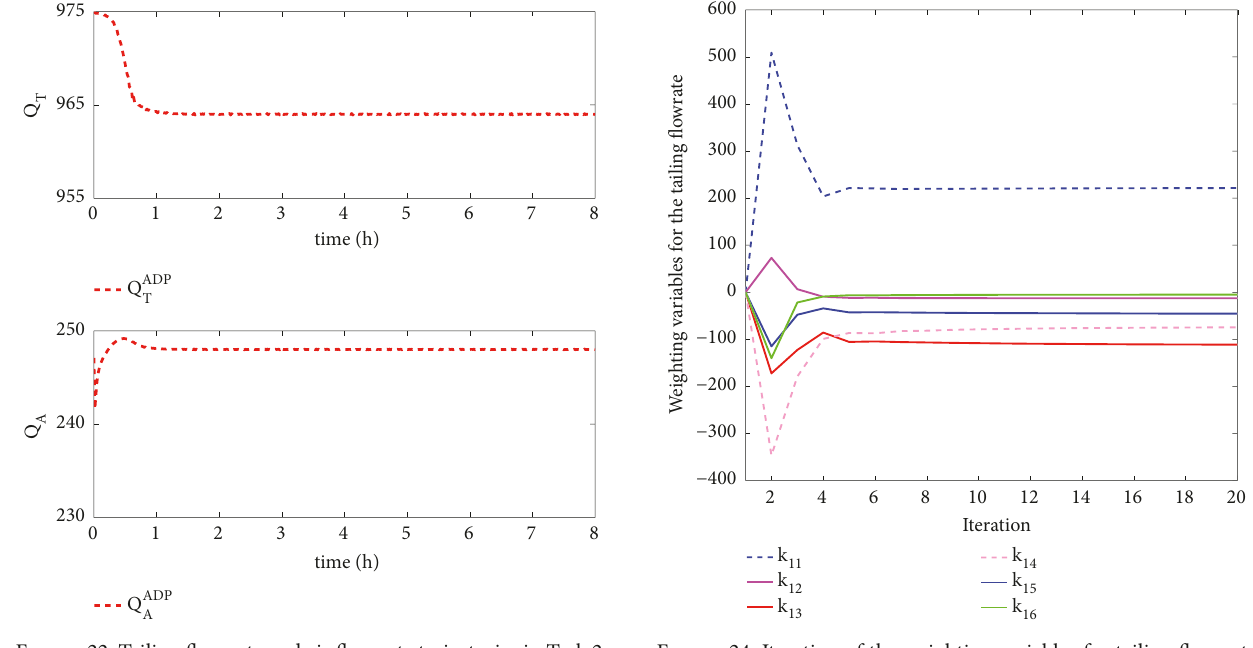
Figure 22: Tailing flow rate and air flow rate trajectories in Task 2.